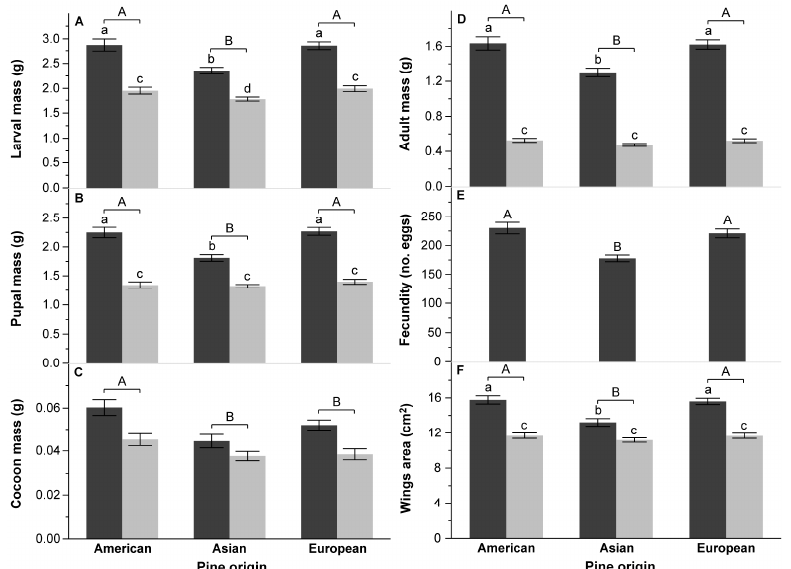
Figure 3. Mean values (±SE) of maximal larval mass ( A ), pupal mass ( B ), cocoon mass ( C ), adult mass ( D ), fecundity ( E ), and wing area ( F ) achieved by the pine-tree lappet ( Dendrolimus pini L.) larvae, which were fed with the needles of pines of different geographical origin (American, Asian, and European) classified by sex: females (dark) and males (light). Lowercase letters above the bars indicate result of Tukey’s post hoc test ( α = 0.05) for pine origin × sex interaction, but uppercase letters indicate result for pine origin treatment (see also Table 1). Levels not connected by same letter are significantly different.